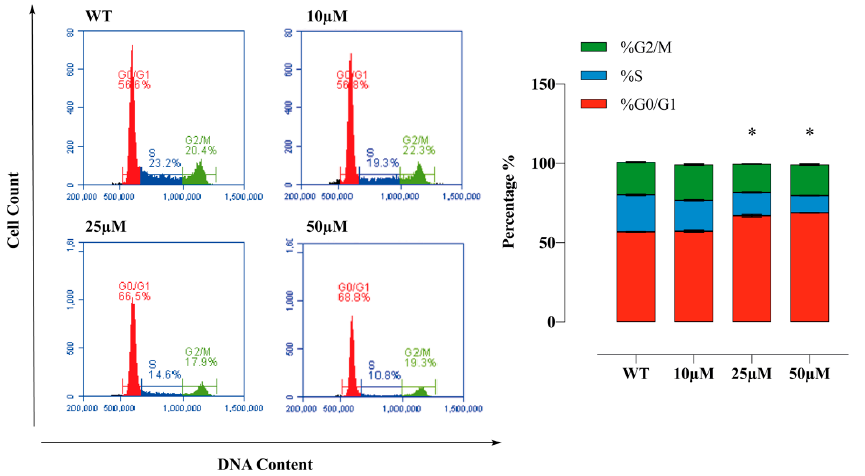
after incubating with the compound E at doses of 10, 25, and 50 µM for 72 h and confirm- ing the presence of 10.000 cells in flow cytometry. The obtained results are as follows. WT: G0/G1 = 56.6%, S = 23.2%, G2/M = 20.4%; 10 µM: G0/G1 = 56.8%, S = 19.3%, G2/M = 22.3%; 25 µM: G0/G1 = 66.5%, S = 14.6%, G2/M = 17.9% and 50 µM: G0/G1 = 68.8%, S = 10.8%, G2/M = 19.3%. Compound E arrested cell cycle of HeLa cells at the G0/G1 phase (Figure 7).